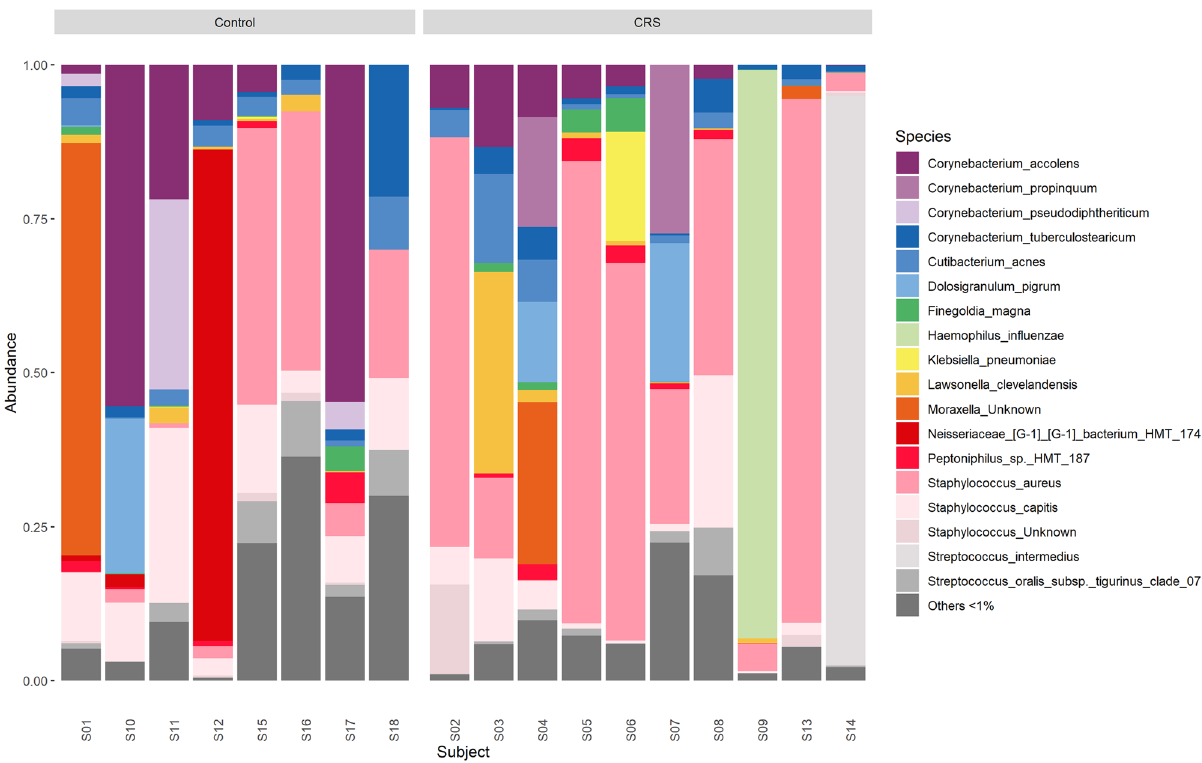
Figure 1. Bacterial community composition of taxonomy-assigned amplicon sequence variants summarized at the species-level in chronic rhinosinusitis (CRS, n = 10) and disease control (n = 8) patients that cultured positive for Staphylococcus aureus . The taxa bar plots display the 18 most abundant bacterial species with all others comprising < 1% of the relative abundance sequencing data grouped in ‘Others’. Taxa bar plots were generated